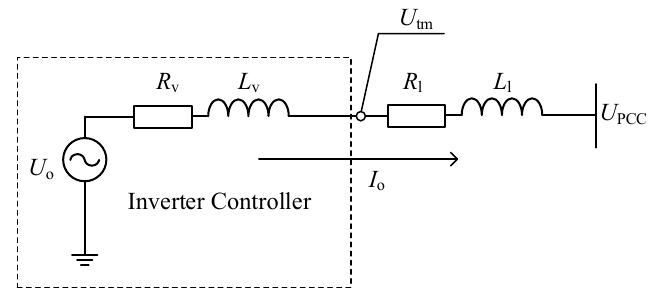
Figure 5. Schematic diagram of the virtual impedance technique.